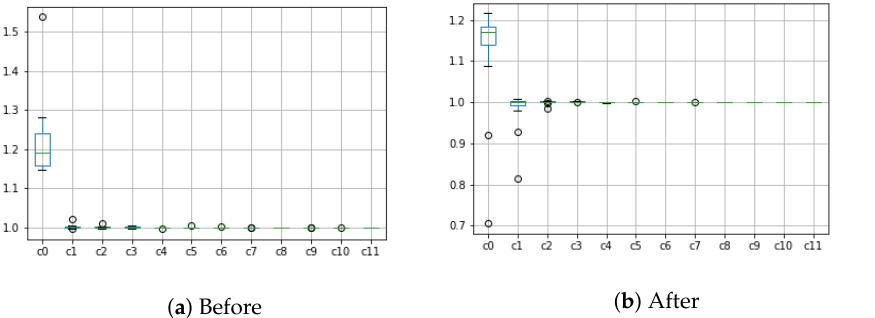
Figure 5. Failed attempt to outlier elimination using the triangle adjustment technique.